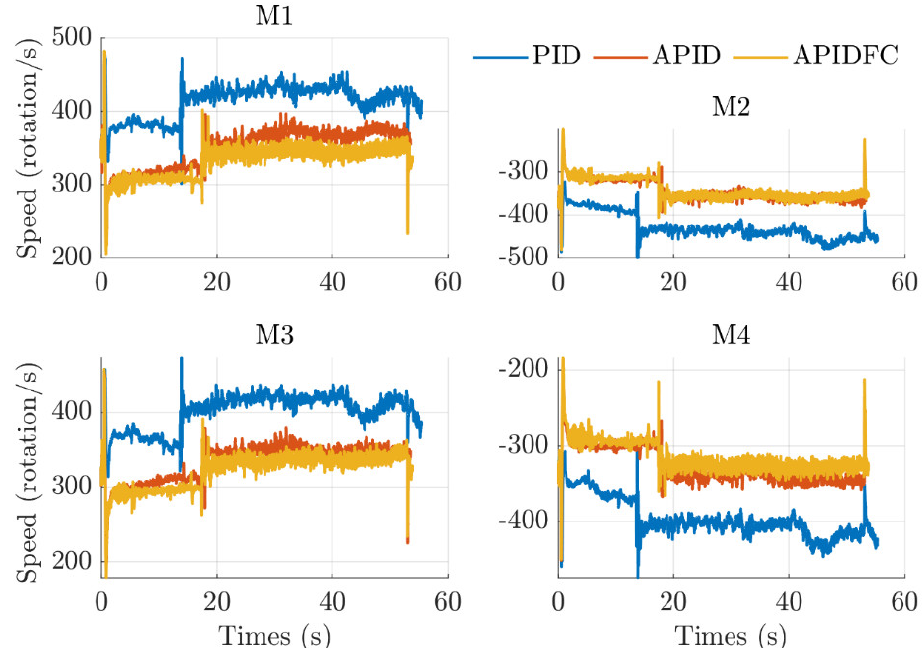
Figure 21. Motors rotation comparison from the experiment.